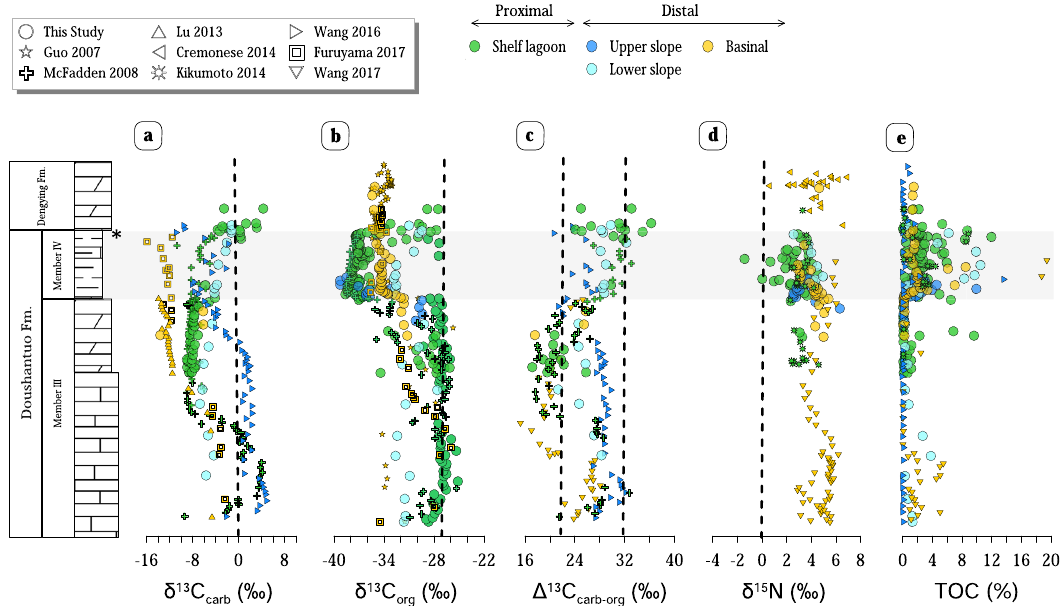
Fig. 1 New chemostratigraphic columns of carbon and nitrogen isotope compositions in Doushantuo Member IV. a Carbonate carbon isotopes. b Organic carbon isotopes. c Carbonate and organic carbon isotopes difference. d Sedimentary nitrogen isotopes. e Total organic carbon content. Data are classi fi ed by depositional environments and, where applicable, shown in comparison with published data 5,26,28 – 30,68 . *U − Pb age of 551.1 ± 0.7 Ma 69 . Vertical dashed lines from left to right show Peedee belemnite, isotopic fractionation imparted to biomass by primary producers typically around − 27 ‰ , photosynthetic range 22 – 32 ‰ based on compilations of Δ 13 C carb-org throughout the Phanerozoic 70 , and lastly δ 15 N for atmospheric N 2 Table 1 Summary of geochemical results.